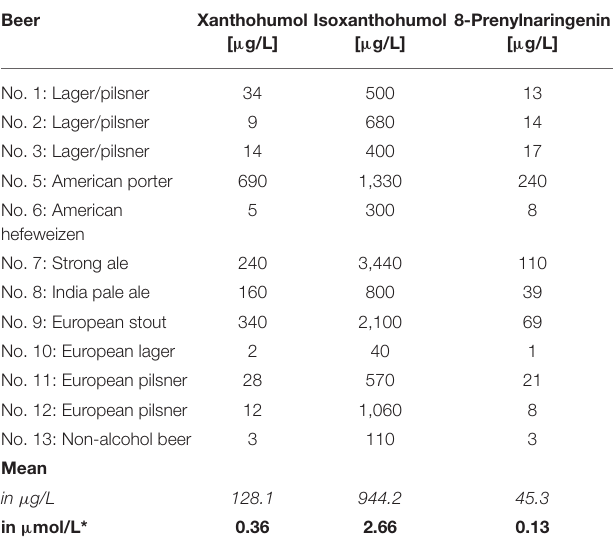
TABLE 2 | Prenylflavonoid and -chalconoid contents in hops and beer measured by LC–MS/MS, adapted from Stevens et al. (24).